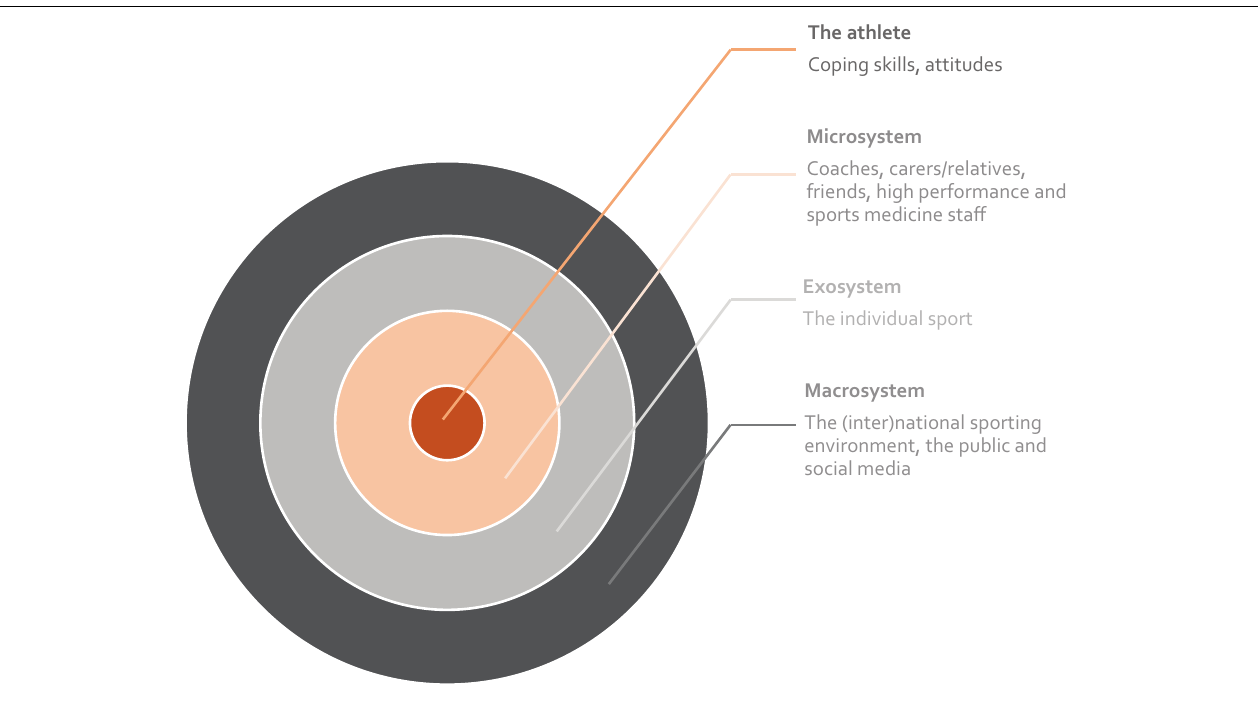
FIGURE 1 | An ecological systems model for responding to elite athlete mental health (from Purcell et al., 2019).